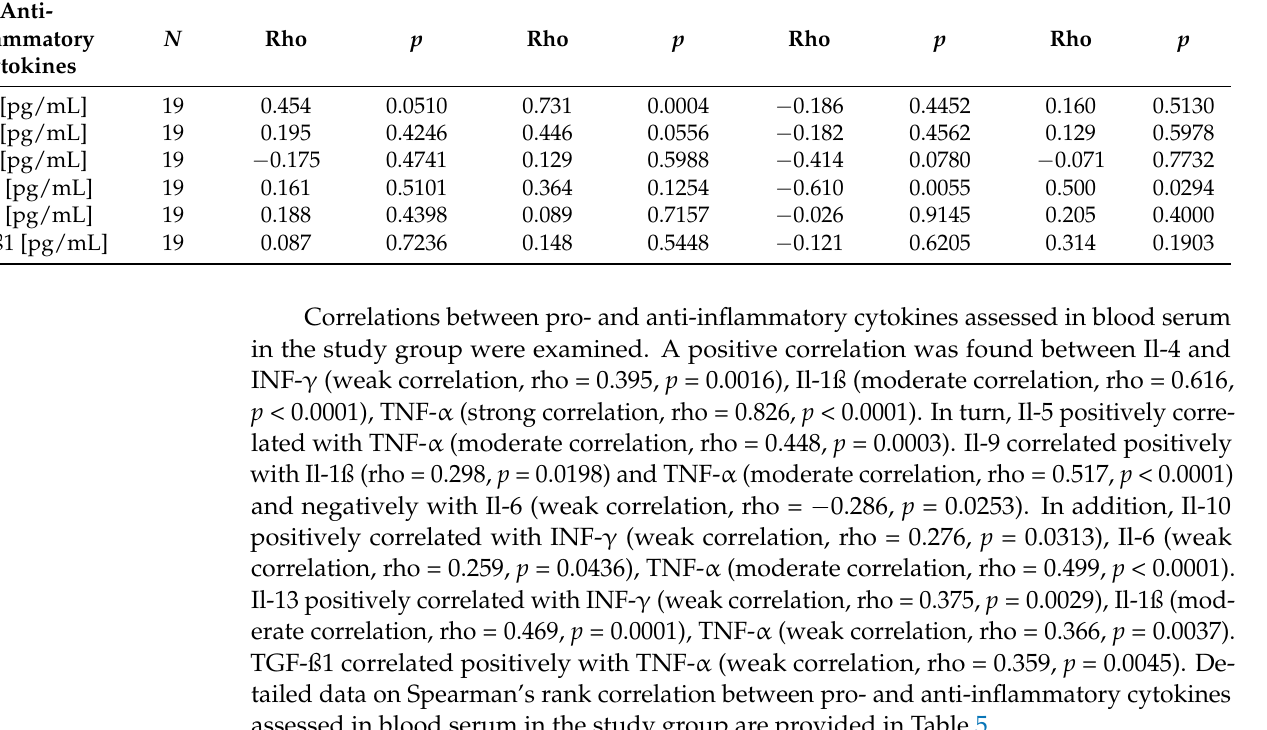
Table 5. Spearman’s rank correlation between pro and anti-inflammatory cytokines evaluated in blood serum in the study group. Pair of Variables